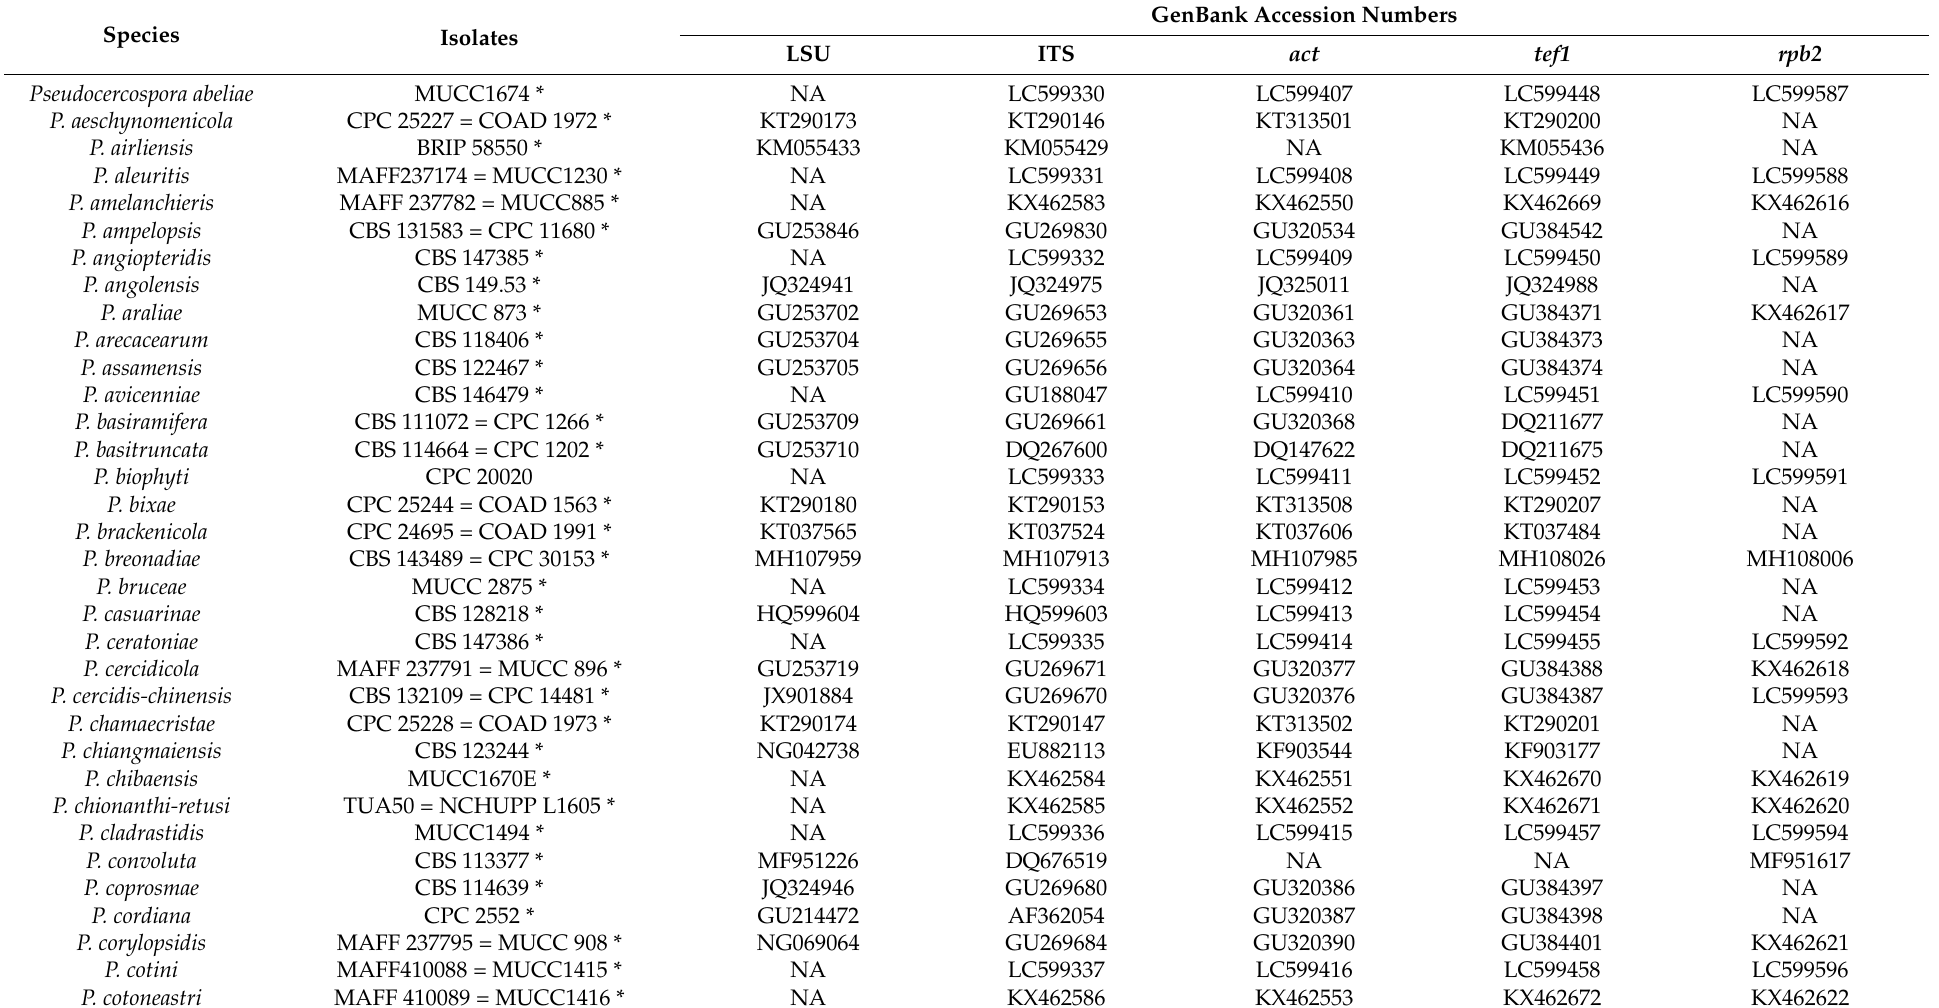
Table 1. Strains and GenBank accession numbers used in this study.